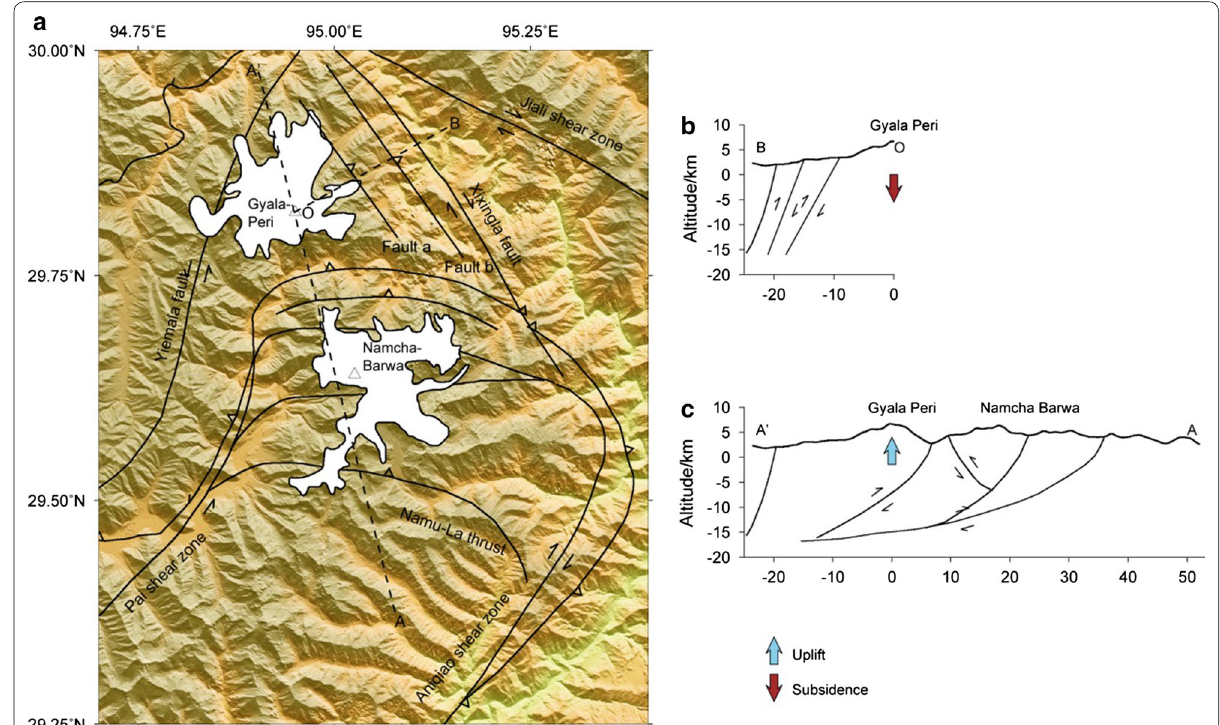
Fig. 9 a Tectonic map around the Namche Barwa syntaxis (Ding et al. 2001; Liu et al. 2018). The dashed lines A–A ′ and O–B indicate the profile locations of b , c . b , c Cross sections of the Namche Barwa